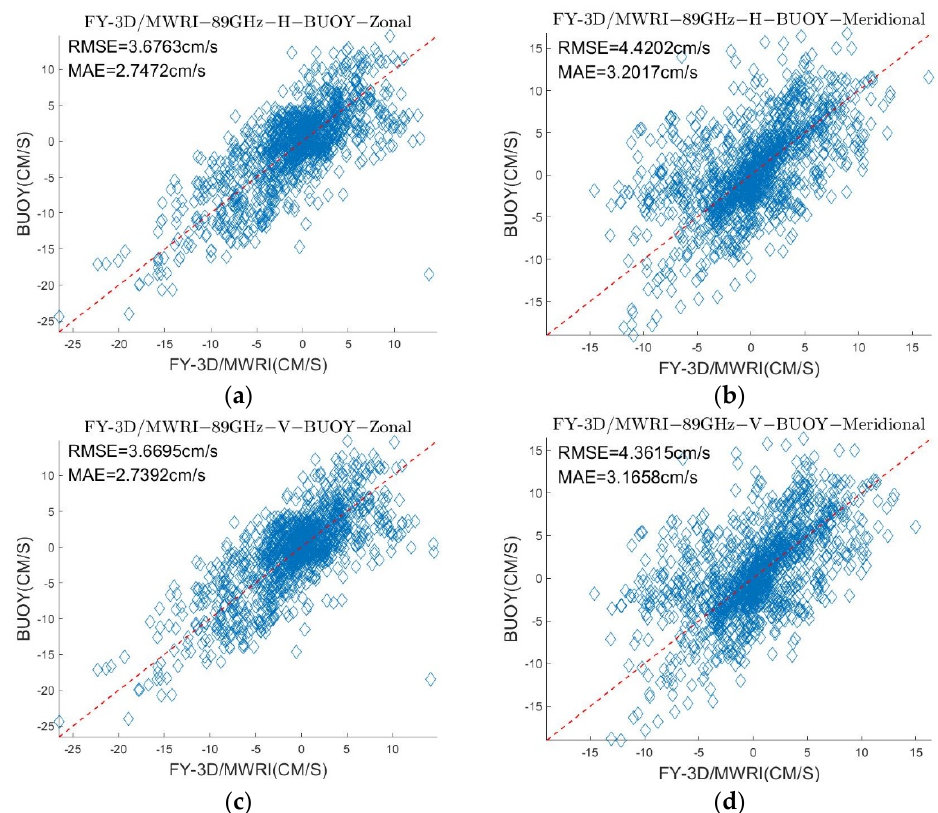
Figure 7. Comparison between the sea ice motion, retrieved from FY-3D/MWRI T b data at 89 GHz with different polarizations, and the motion of the buoy. ( a ) is a scatter diagram of the sea ice motion retrieved by using FY-3D/MWRI T b data at 89 GHz with H polarization and the motion of the buoy in the zonal direction, ( b ) is a scatter diagram of the sea ice motion retrieved by using FY-3D/MWRI T b data at 89 GHz with H polarization and the motion of the buoy in the meridional direction, ( c ) is a scatter diagram of the sea ice motion retrieved by using FY-3D/MWRI T b data at 89 GHz with V polarization and the motion of the buoy in the zonal direction, and ( d ) is a scatter diagram of the sea ice motion retrieved by using FY-3D/MWRI T b data at 89 GHz with V polarization and the motion of the buoy in the meridional direction. Table 3. Error ‐ related statistics of the retrieved sea ice motion from FY ‐ 3D/MWRI T b data at 89 GHz Table 4. Error-related statistics of the retrieved sea ice motion from FY-3D/MWRI T b data at 36.5 GHz in the Beaufort Sea.